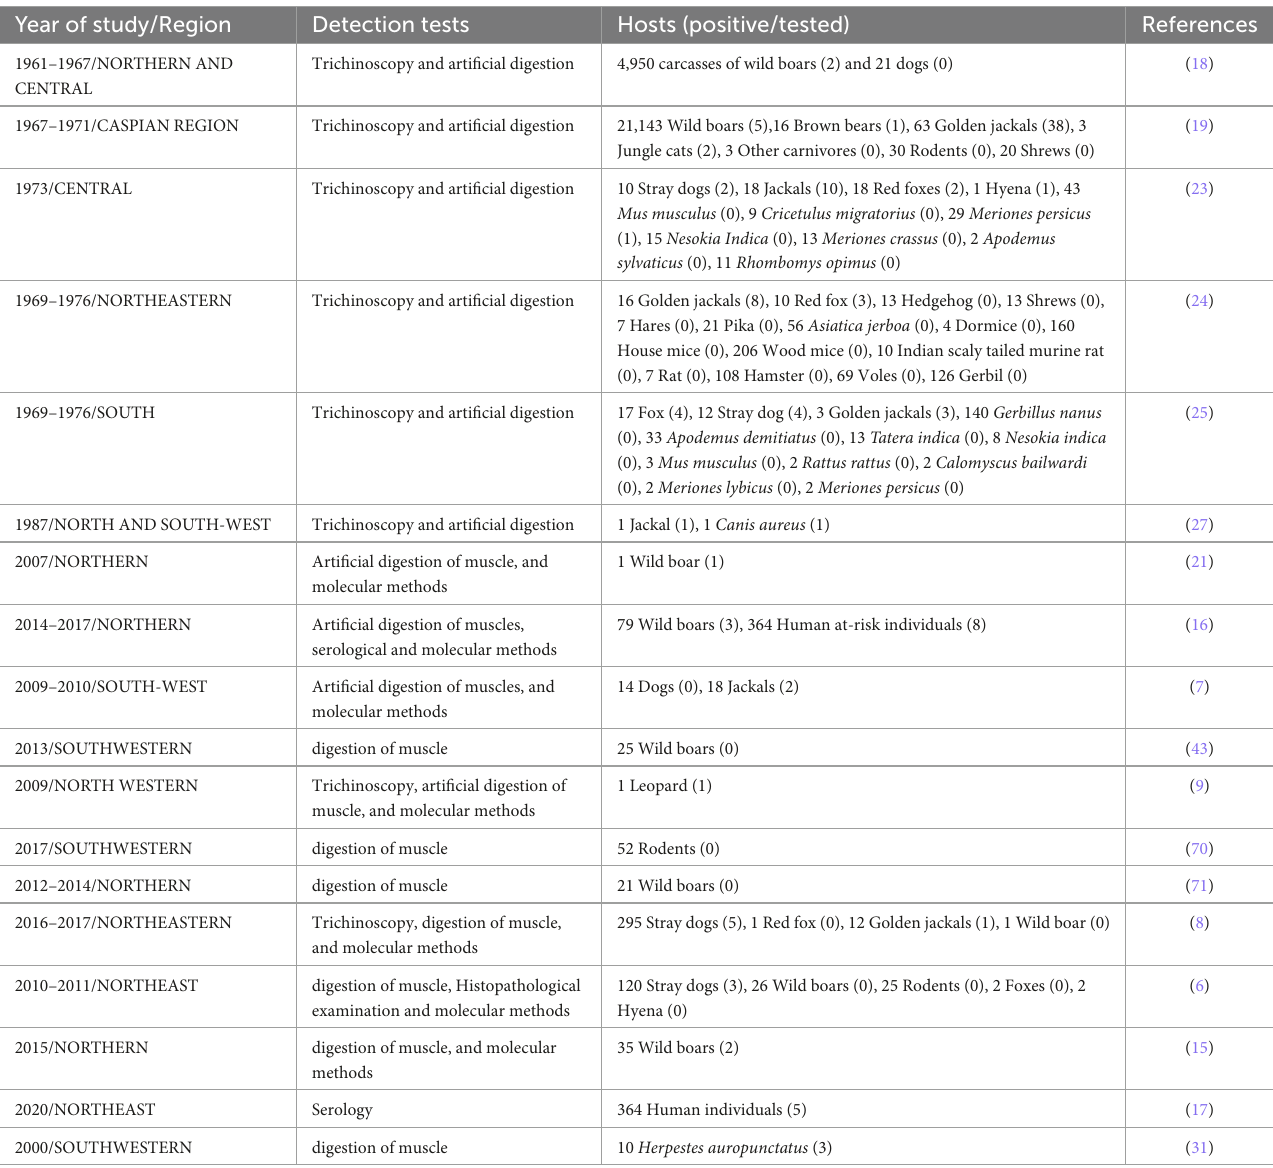
TABLE 1 Epidemiological investigations on Trichinella sp. in human and animals of Iran. Year of